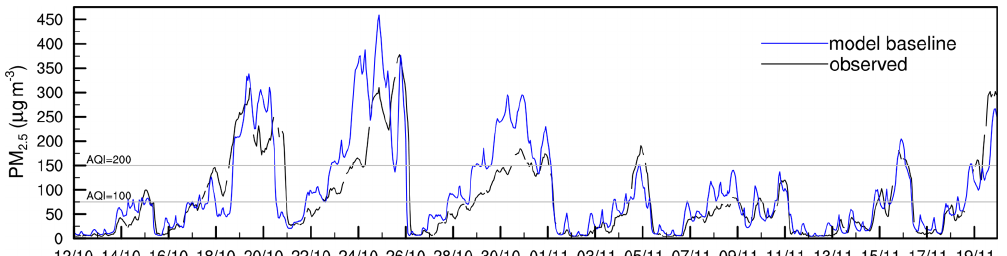
Figure 1. Average observed and simulated PM 2 . 5 over 12 stations in Beijing in October–November 2014. The national air quality standard for 24h average PM 2 . 5 of 75µgm − 3 and the threshold for heavy pollution, 150µgm − 3 , are indicated.